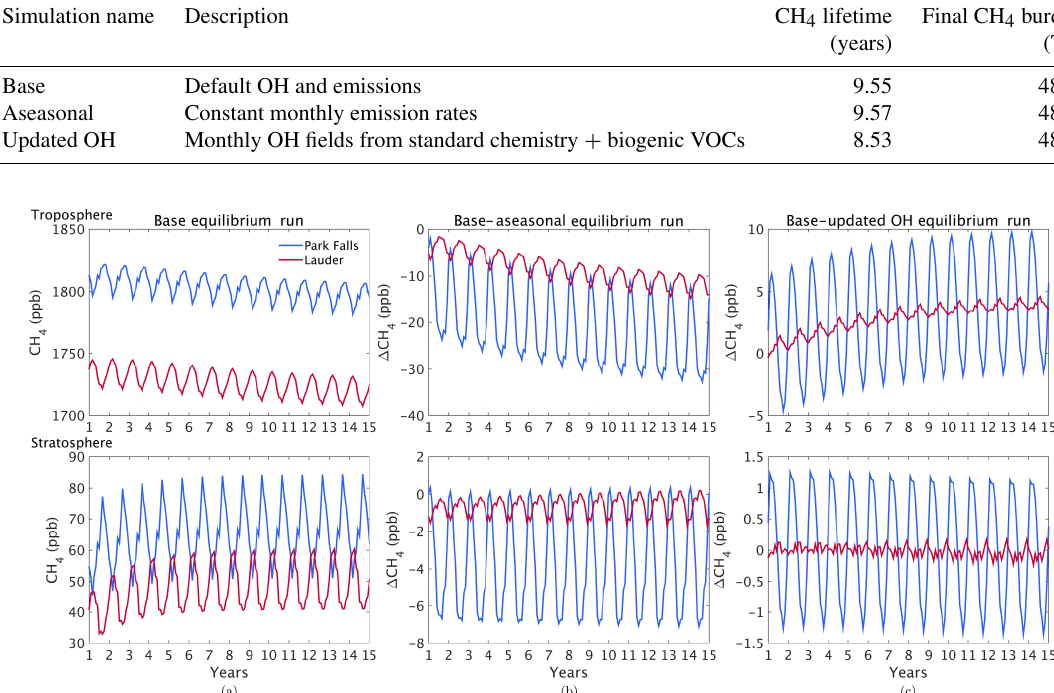
Figure 3. Smoothed daily mean X t and stratospheric contribution to X CH at Park Falls (blue) and Lauder (red) for (a) base equilibrium CH 4 4 simulation and the difference between the base and (b) aseasonal and (c) updated OH